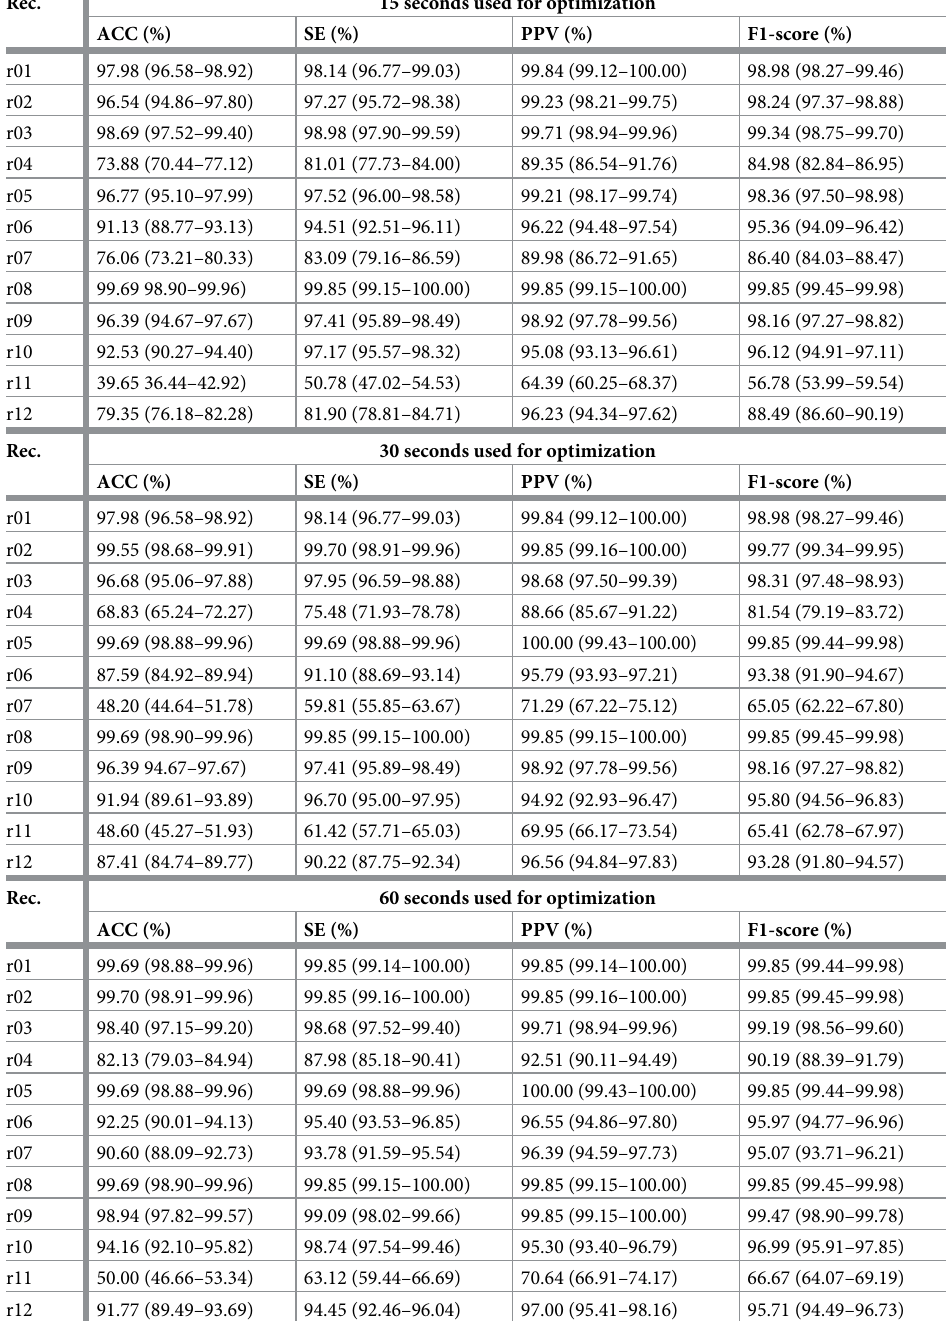
Table 12. Statistical evaluation of the detection of fQRS complexes for the whole recording, while optimizing the method only on the signal section with a length of 15, 30 and 60 seconds (the 95% confidence interval is reported in